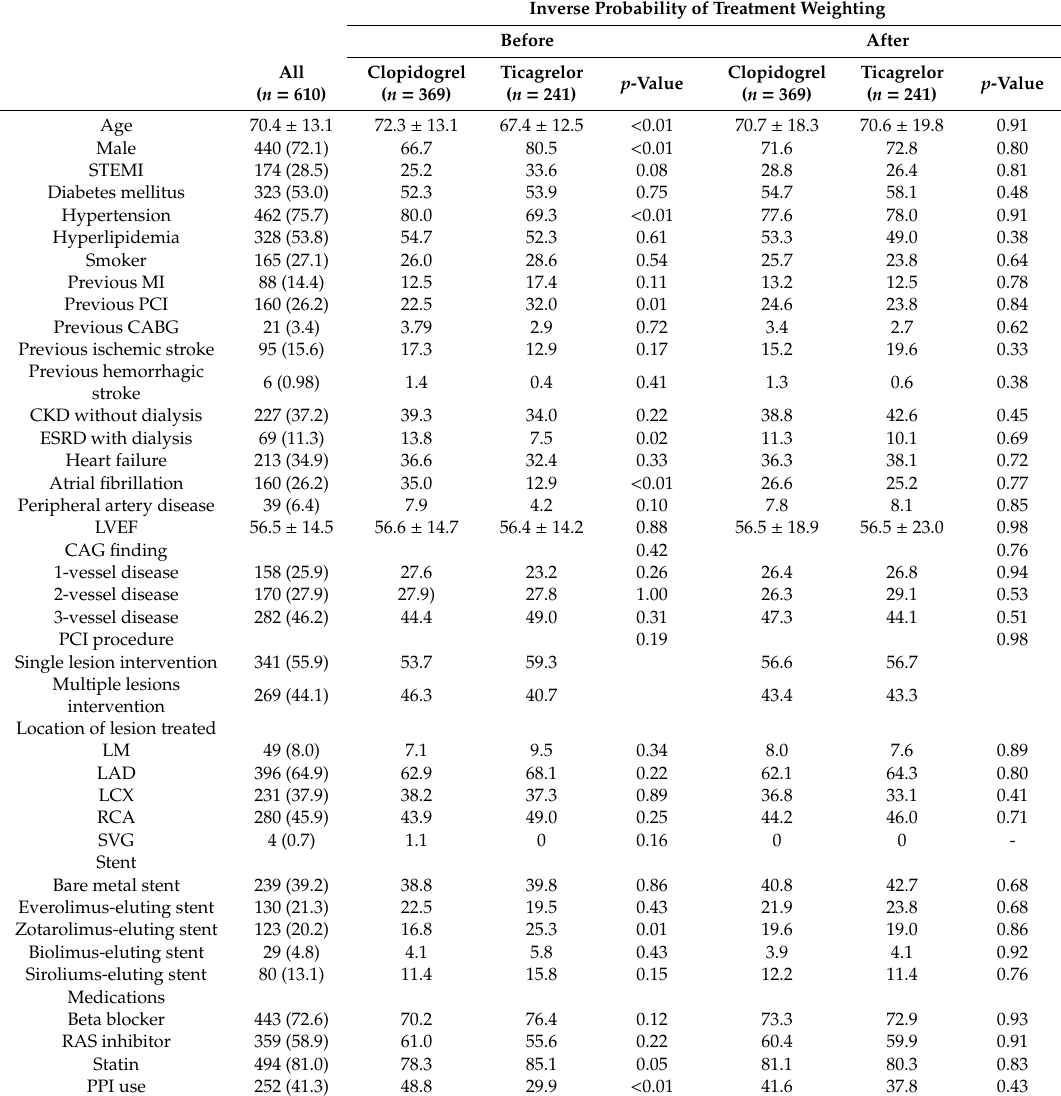
Table 2. Baseline characteristics of patients treated with clopidogrel versus